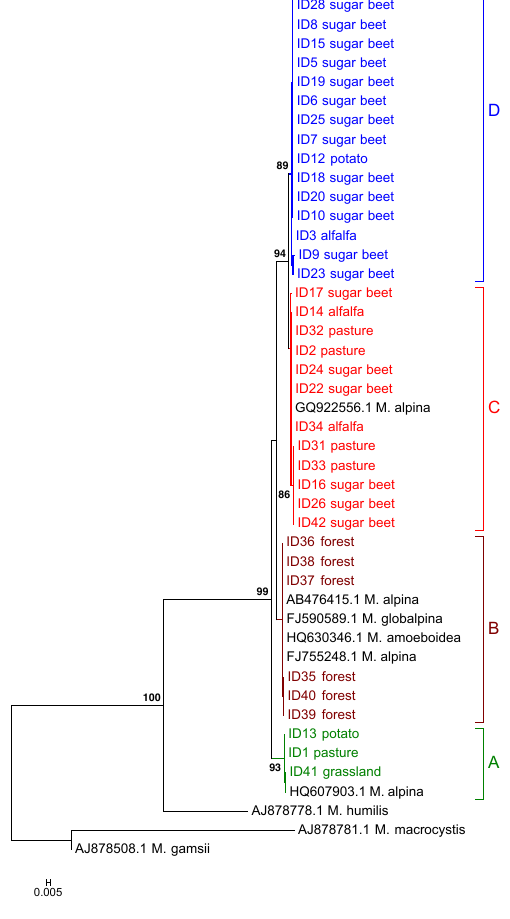
Figure 1. Neighbor-joining tree based on ITS sequences. The evo- lutionary distances were computed using the Tamura 3-parameter method (Tamura, 1992); units are the number of base substitutions per site. The rate variation among sites was modeled with a gamma distribution (shape parameter = 0.25). Node support above 75% is given. Note that the reference sequences named as M. globalpina and M. amoeboidea are also placed within the M. alpina complex as found by Wagner et al.